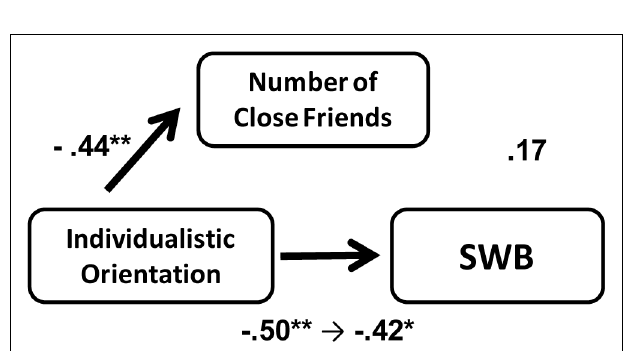
orientation is a single independent variable.Those on the right side of the arrow indicate standardized regression coefficients when both individualistic orientation and the number of close friends are independent variables. Gender and age were controlled. ** p < 0.01, * p < 0.05.